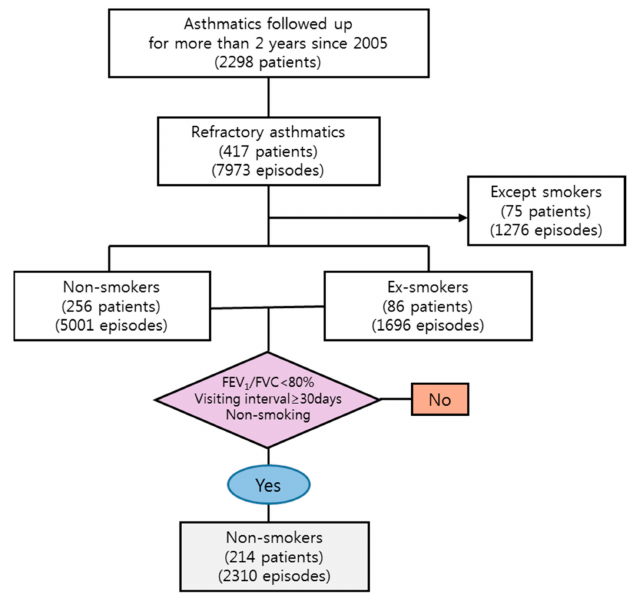
Figure 2. Flow chart for selecting process of study population from the cohort database of Department of Internal Medicine, Soonchunhyang Bucheon hospital. FEV 1 : forced expiratory volume during the first second; FVC: forced vital capacity.